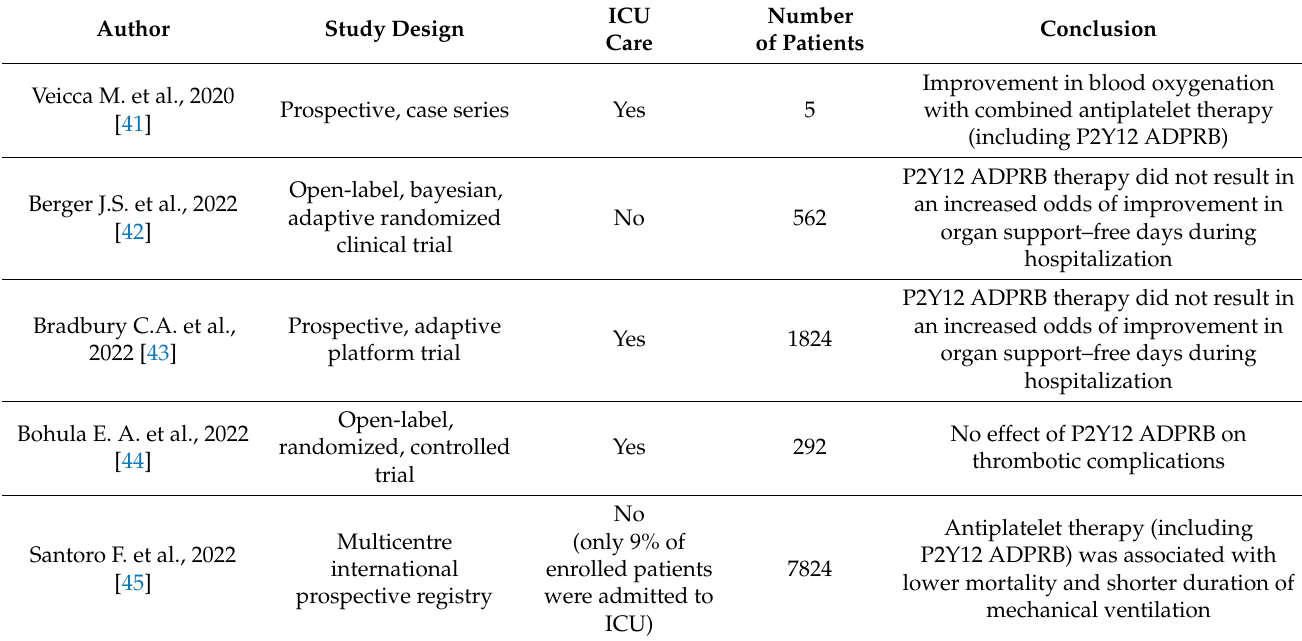
Table 2. P2Y12 ADPRB therapy in patients with COVID-19 [41–45].